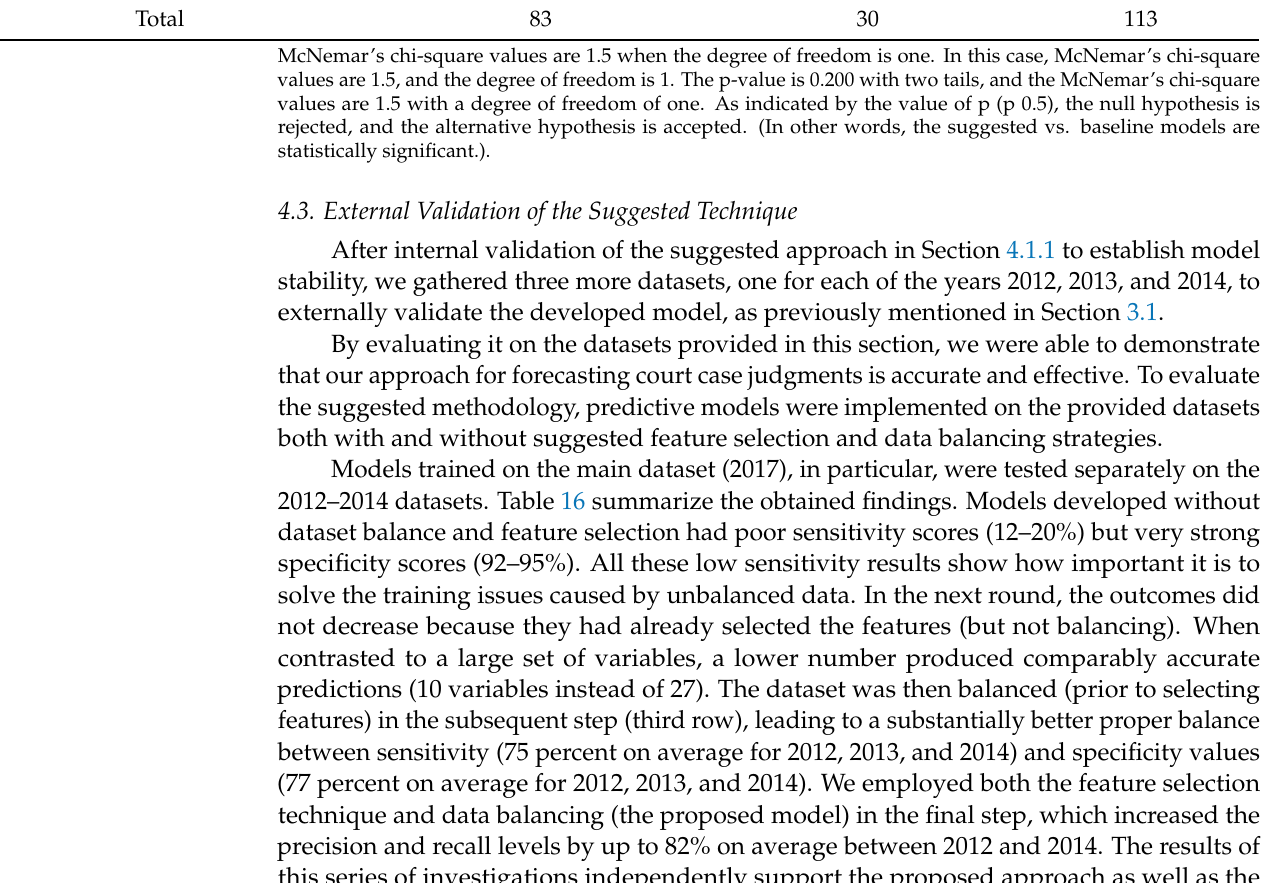
Table 15. Differences in the efficiency of LR(ML) and LSTM-CNN(DL) via significant testing. True Classification with the LR Misclassification of the LR Total LSTM-CNN classification that is correct 71 10 81 Misclassification of the LSTM-CNN 12 20 32 Total 83 30